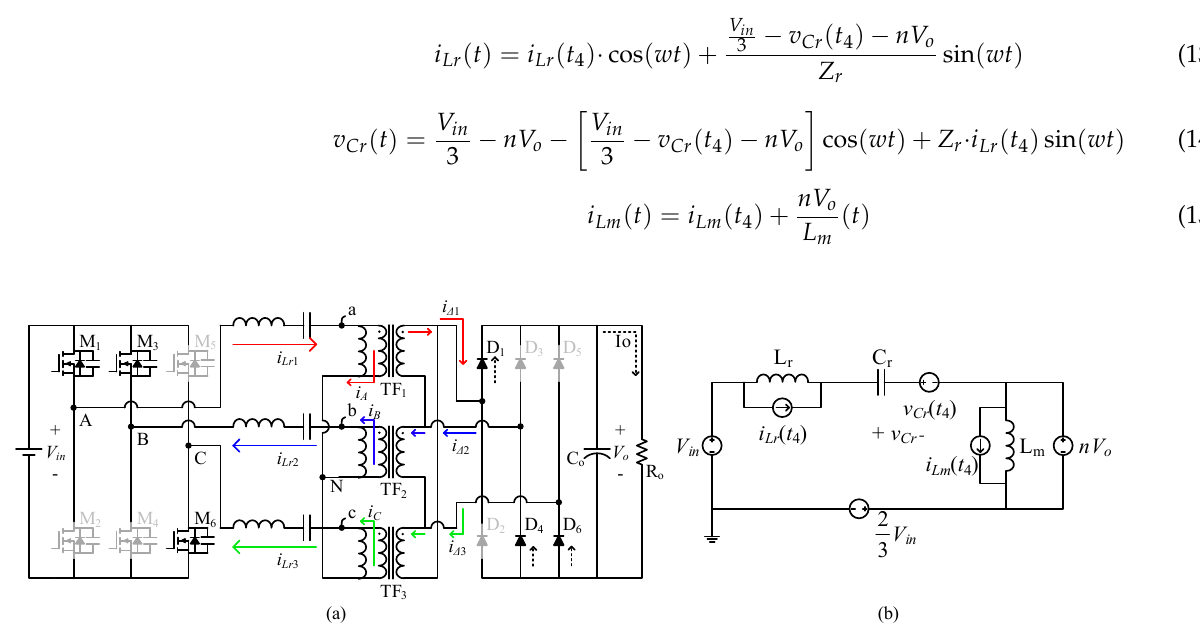
Figure 8. ( a ) Circuit station at Stage 5 ( b ) Equivalent circuit at Stage 5.